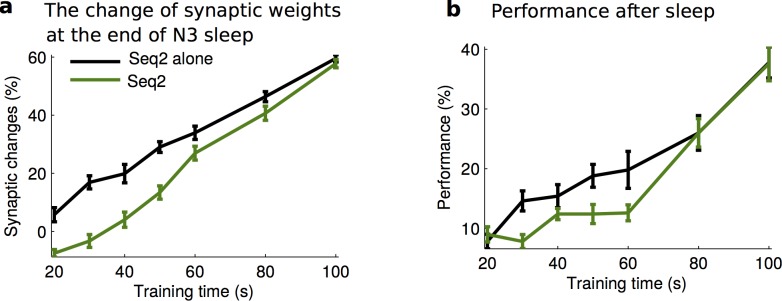
The effect of memory strength on the consolidation during slow oscillations.a) The dynamics of synaptic weights associated with Seq2 after N3 sleep for the different training duration (memory strength) of Seq2. The black line represents Seq2 trained alone. The dark green line indicates Seq2 trained along with the stronger Seq1. b) The change of Seq2 performance for the different training duration of Seq2. As the memory strength of Seq2 increased (longer training), the impact of interference on the synaptic weights and performance on Seq2 decreased. Error bars indicate SEM.